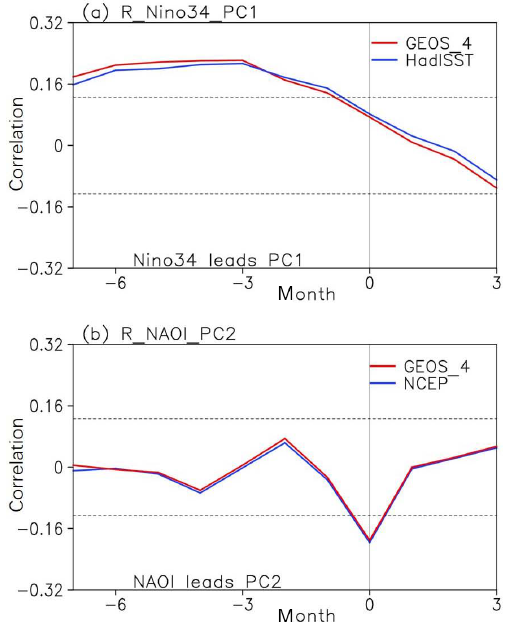
Figure 3. (a) Lead–lag correlation between the Niño 3.4 index and PC1. Negative (positive) lags indicate that the Niño 3.4 index is leading (lagging), and the dashed lines are the 0.05 significance lev- els. (b) As in (a) but for the correlation between the NAOI and PC2. The red lines are based on the GEOS-4 meteorological fields, and the blue lines are based on the